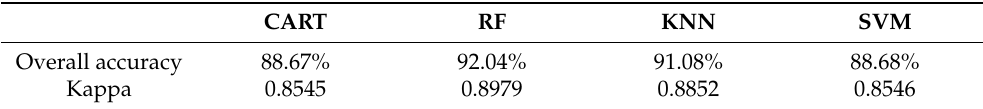
Table 5. Overall accuracy and kappa coefficient of Fm with different classifiers. CART RF KNN SVM Overall accuracy 88.67% 92.04% 91.08% 88.68% Kappa 0.8545 0.8979 0.8852